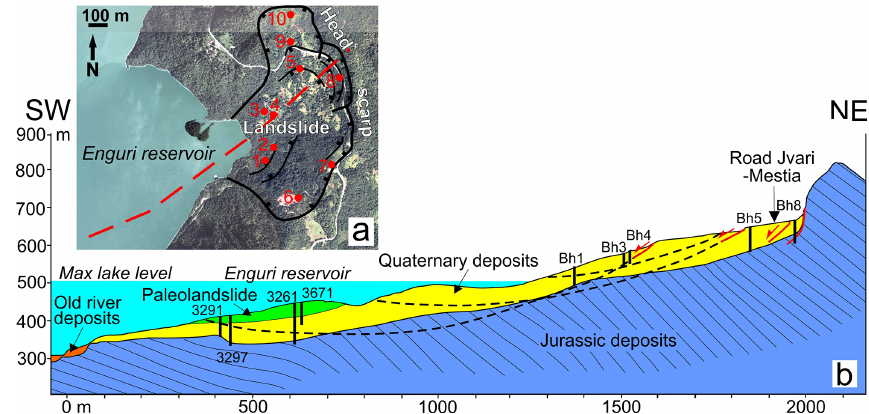
Figure 4. (a) Trace (dashed red line) of the geological section and location (red dots) of the piezometers described in Table 1. Black lines are major landslide scarps (© Google Earth 2021). (b) Geological section across the slope facing the Enguri reservoir. Black columns represent locations and depth of logs used to construct the cross section. Dashed black lines are the main potential slip surfaces calculated through a static analysis by Tibaldi et al. (2019); red lines with arrows are landslide scarps surveyed in the field. Data of the submerged part are derived from geological surveys made in the Soviet era, before the construction of the